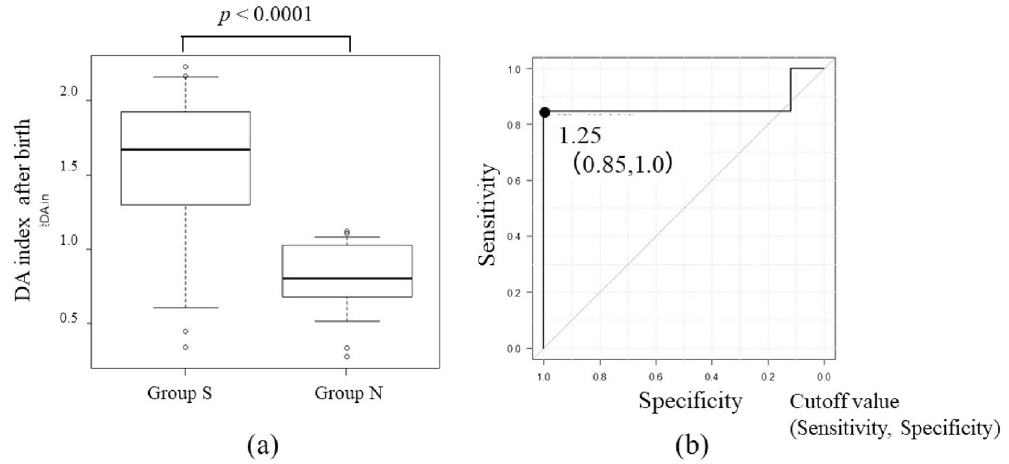
Figure 4. Ratio of cardiac parameter and ROC curve of DA index after birth. ( a ) Box-and-whisker diagram comparing each ratio of DA index after birth. ( b ) ROC of DA index after birth. ROC receiver operator characteristic curves, DA distal aortic